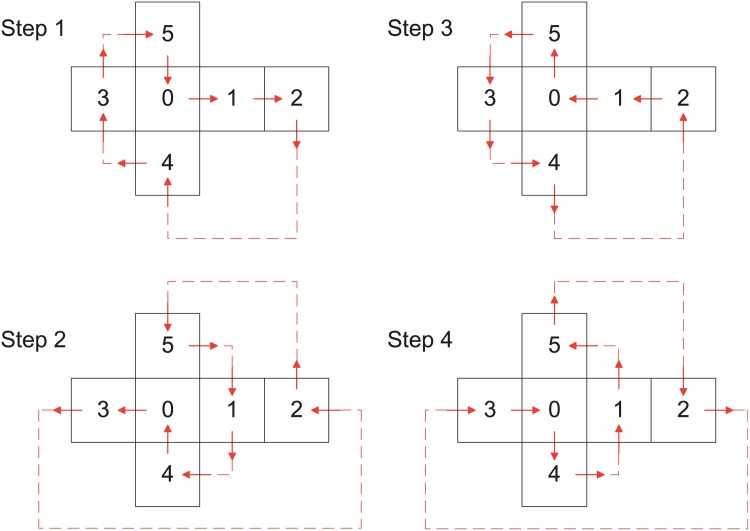
The “pipe-flow” communication scheme with four steps.Arrows indicate the directions that data flows the six patches. At each step, each patch only has one data in (MPI receive) and one data out (MPI send), leading to a better load balance systematically.